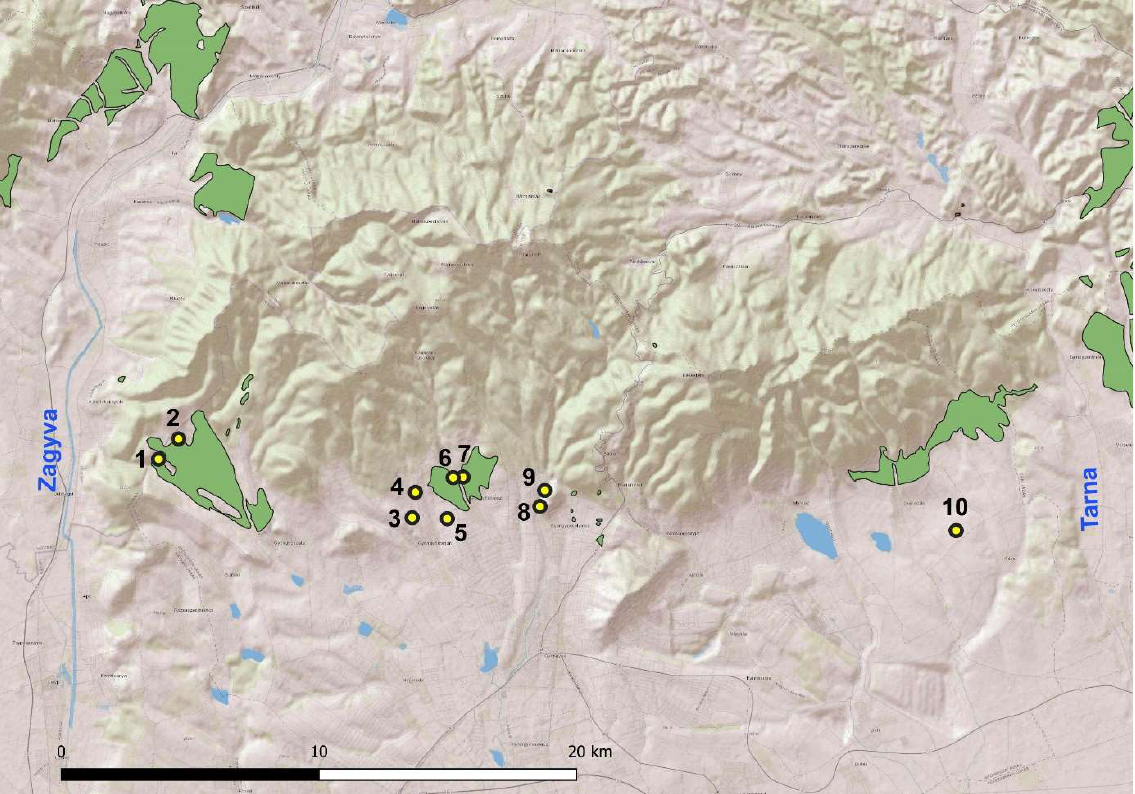
Figure 3. Map of the Mátra Mountains with the geological formations containing siliceous rocks (green patches), according to the geological map of the Mining and Geological Survey of